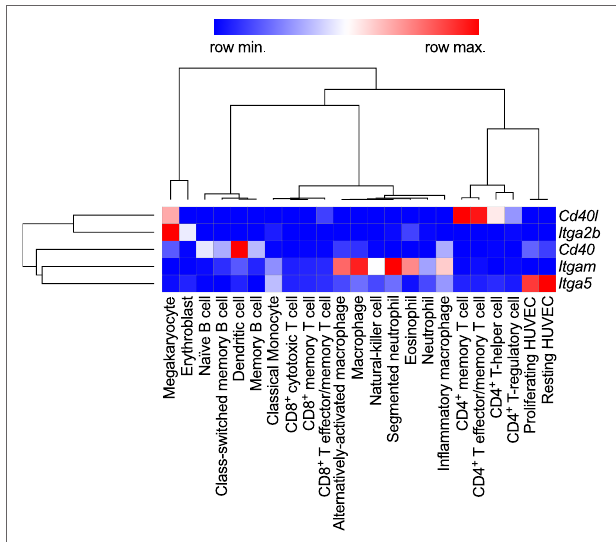
FigURe 2 | Gene expression patterns of CD40L and its receptors in human immune cell types. Baseline gene expression of different human immune cell types quantified by RNAseq was extracted from the Protein Expression Atlas of the European Bioinformatics Institute (EMBL-EBI) (33). Expression values were retrieved as FPKMs, underwent hierarchical clustering and normalization as row scores by Morpheus (Broad Institute). Gene names are encoding for the proteins as follows: Cd40lg : CD40L; Itgb2 : integrin subunit α 2b (CD41); Cd40 : CD40 receptor; Itgam : integrin subunit α M (CD11b); Itga5 : integrin subunit α 5 (CD49e).